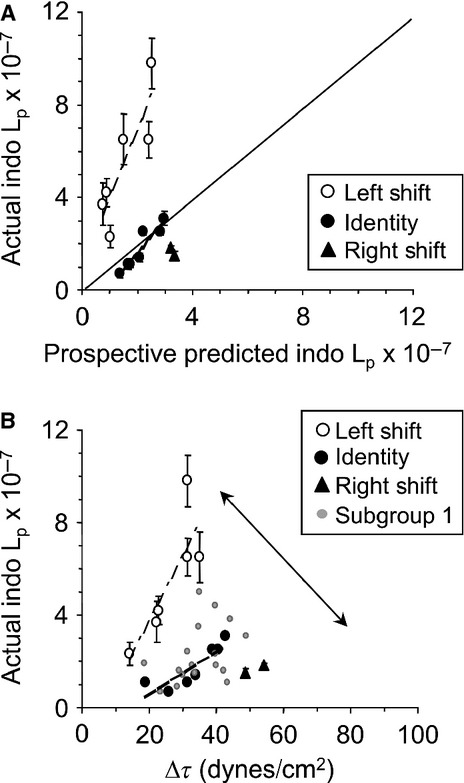
Prospective evaluation of prediction model for Test Subgroup 1 capillary hydraulic conductivity (Lp ± SD × 10−7 cm·sec−1·cm H2O−1) with indomethacin. (A) Predicted Lp versus actual Lp assessed on capillaries during indomethacin treatment where three subsets, Left Shift (open circles, dot-dash line), Identity (black closed circles, dashed line), and Right Shift (closed triangles) were identified. Solid line = line of identity (B) Actual TC2 Lp (indomethacin) plotted as a function of change in shear stress (Δτ). Left Shift subset: Lp = −1.9 + 0.28(Δτ), R2 = 0.69, P = 0.04; Identity subset: Lp = −1.3 + 0.09(Δτ), R2 = 0.75, P = 0.01. Original data from Test Subgroup 1 (Figure2C, gray closed circles) have been added for comparison. Double arrowhead solid line: span of capillary Lp tone.